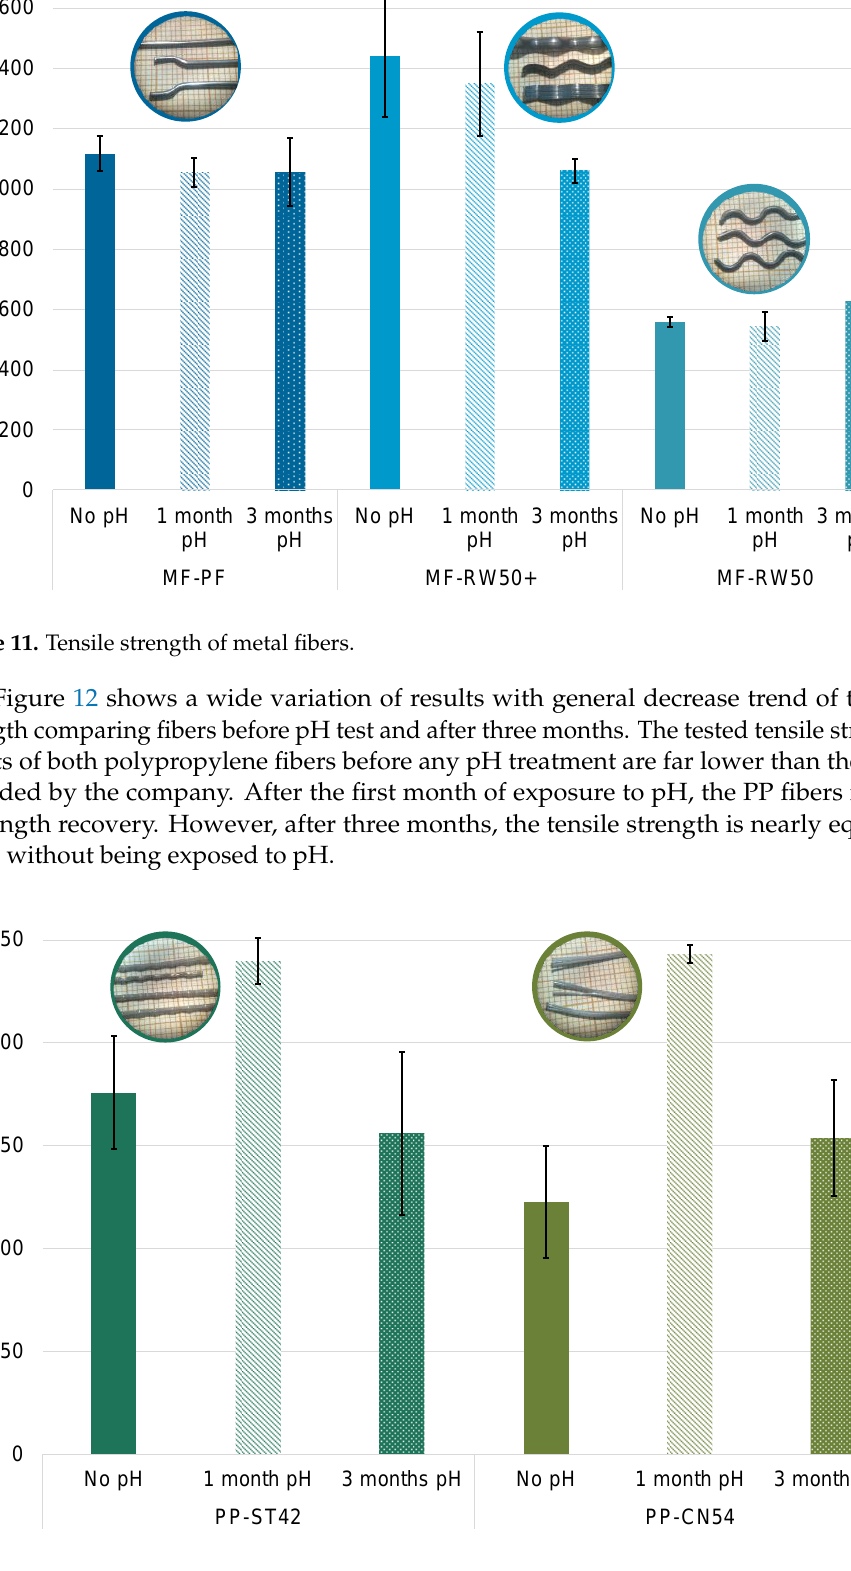
Figure 12. Tensile strength of polypropylene fibers.